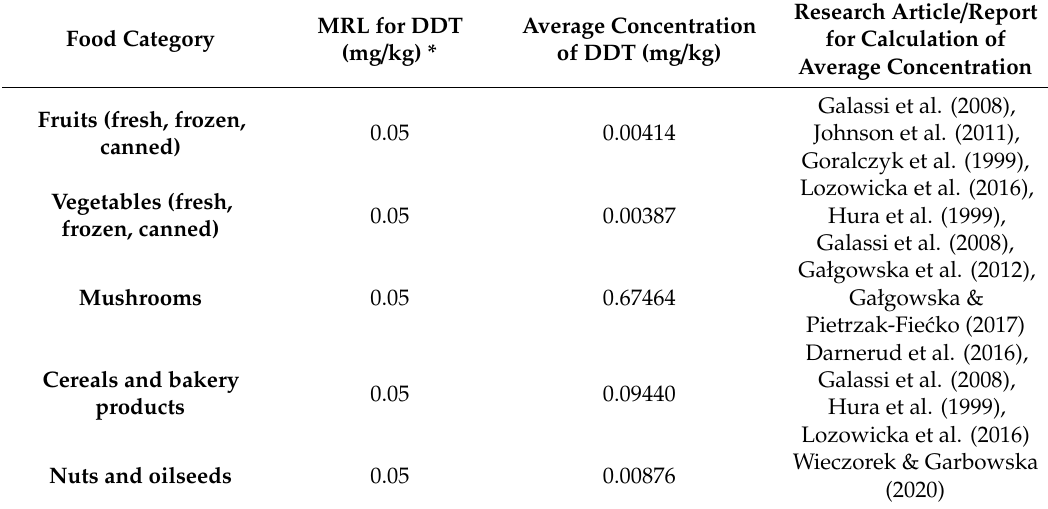
Table 4. Average DDT levels and maximum residue levels of the food